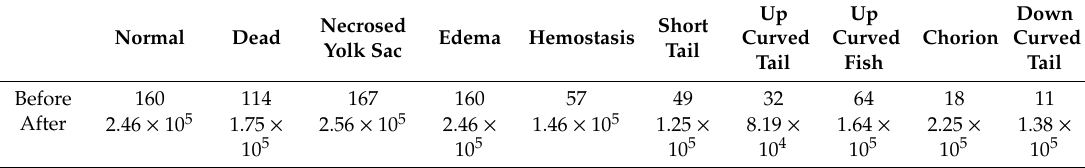
Table 2. The number of training images of each phenotype before and after data augmentation.